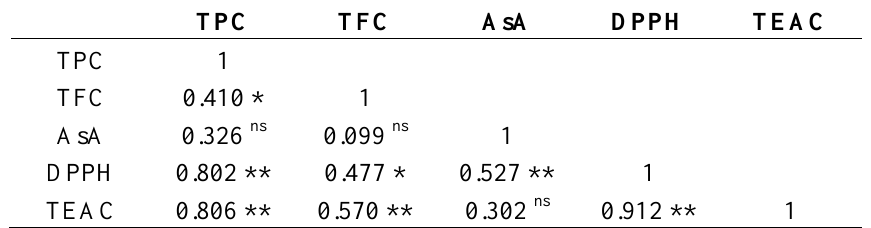
Table 4. Correlation coefficients between antioxidant content and antioxidant activity. TPC TFC